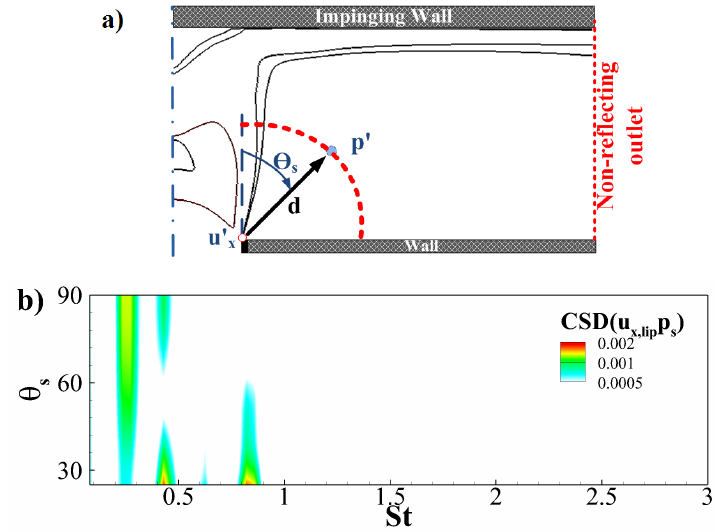
Figure 12. ( a ) Schematic of the sample location of the streamwise velocity and near-field pressure fluctuations; and ( b ) the cross-spectrum density of the streamwise velocity fluctuations near the nozzle lip and the near-field pressure fluctuations at sample